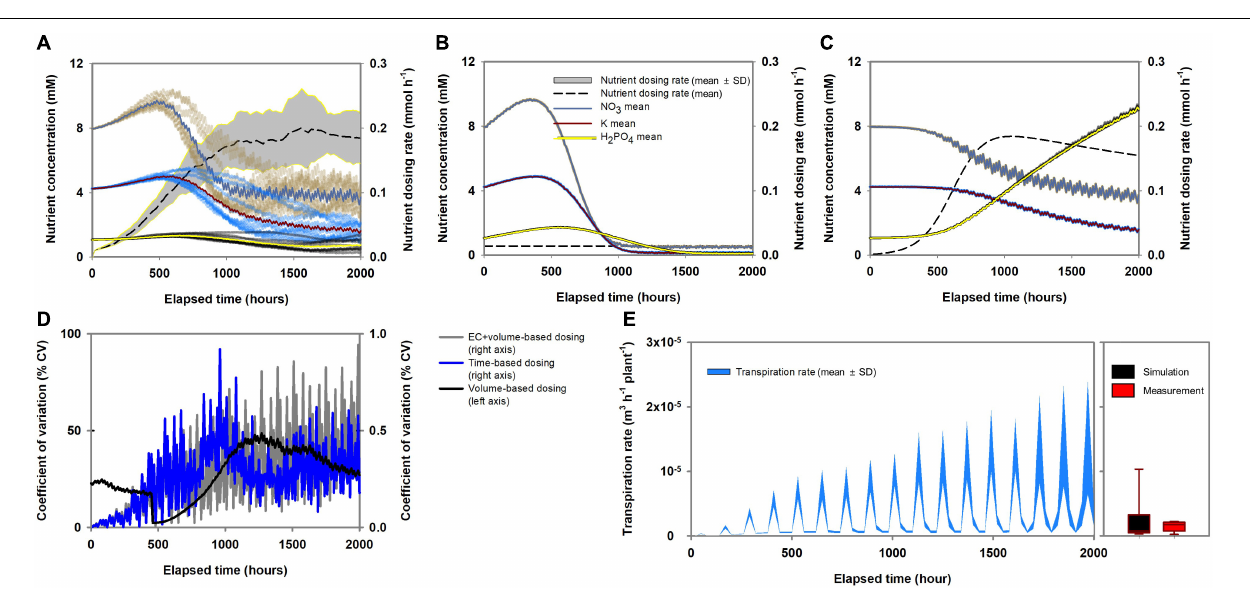
FIGURE 5 | Characteristics of variations in root-zone nutrient concentration according to the nutrient dosing methods (pakchoi parameter applied simulation): (A) volume-based, (B) time-based, and (C) EC + volume-based methods. (D) The percent coefficient of variation of root-zone nutrient concentration according to the nutrient dosing methods. (E) Level of stochastic changes in the transpiration rate during the simulation analysis and box-plot comparing the distribution of the simulated transpiration rate (pakchoi parameter applied simulation) and the measured transpiration rate of